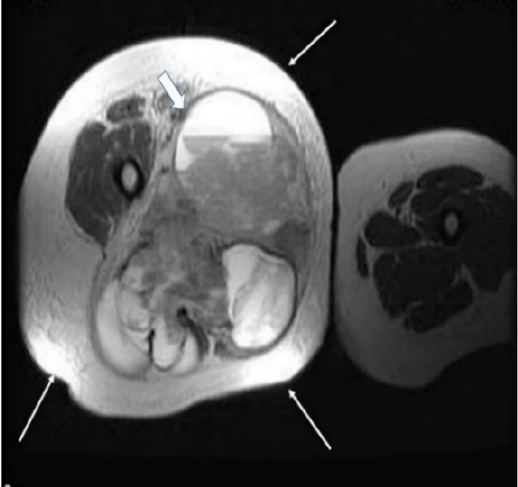
Figure 2. A 40-year old female patient with synovial sarcoma. Image represents an axial MRI of the proximal right thigh—axial T2 FSE (fast spin echo) and FATSAT (fat saturation). There is an increased diameter of the right thigh because of a soft tissue mass (thin arrows), where an inhomogeneous mixture of solid and cystic areas is shown (block arrow).